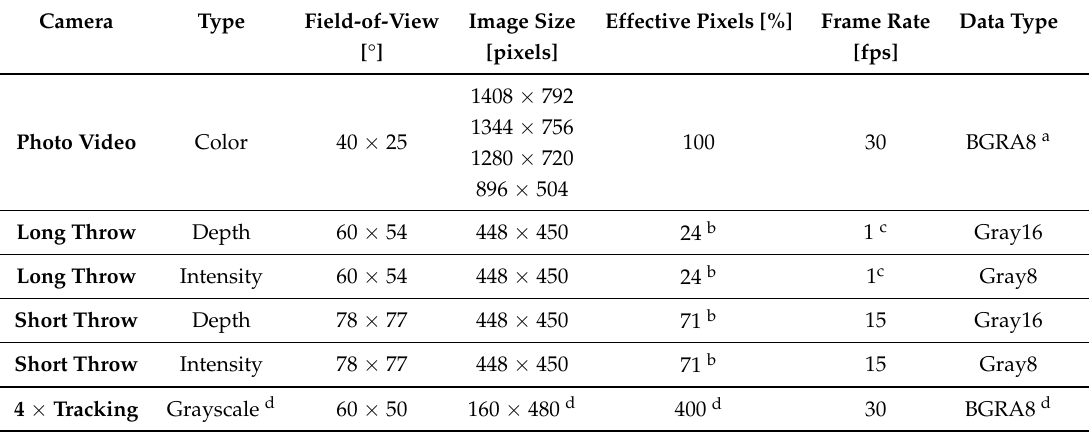
Table 1. HoloLens camera sensors and their characteristics as indicated by the Microsoft Windows 10 SDK for the